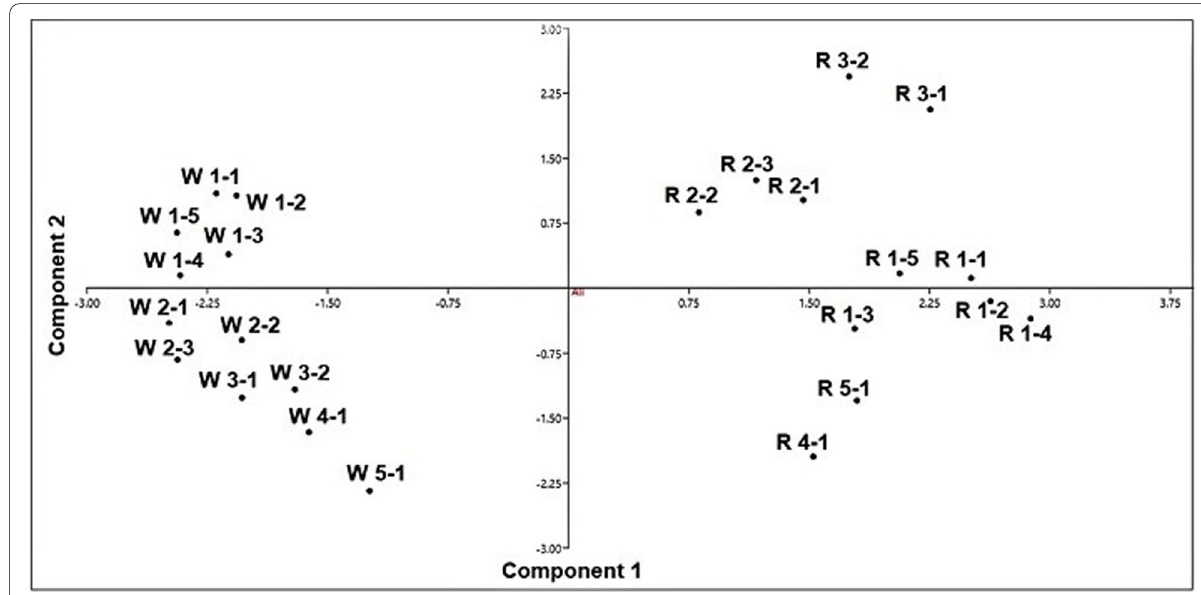
Fig. 4 PCA scatter diagram illustrating the separation of the wild accessions from their regenerated genotypes, as two distinct groups and the differentiation of regenerated